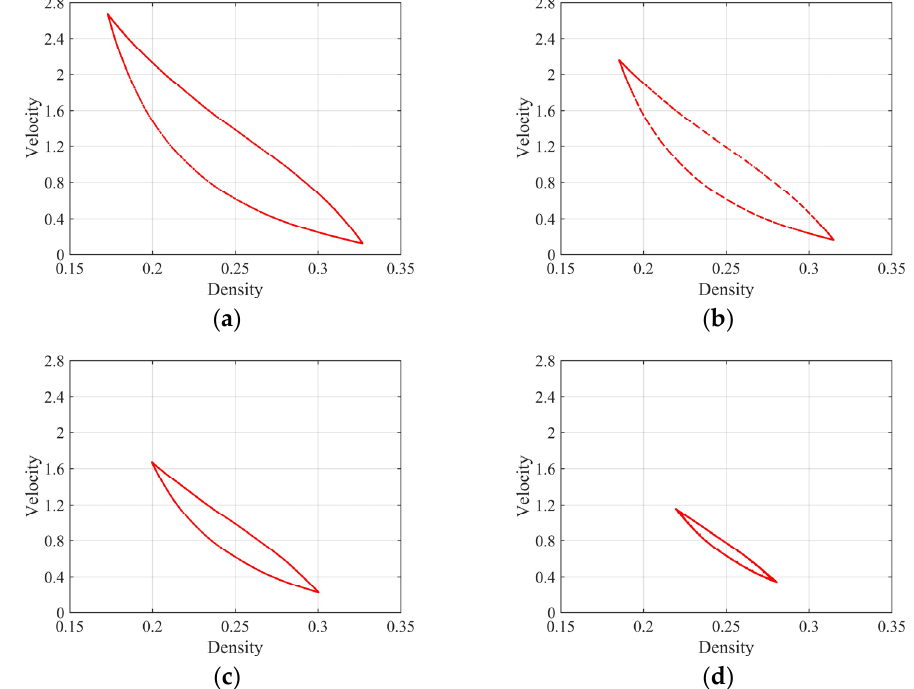
Figure 7. The hysteresis loops of velocity and density for different ξ . ( a ) ξ = 0, ( b ) ξ = 0.1, ( c ) ξ = 0.2, ( d ) ξ =